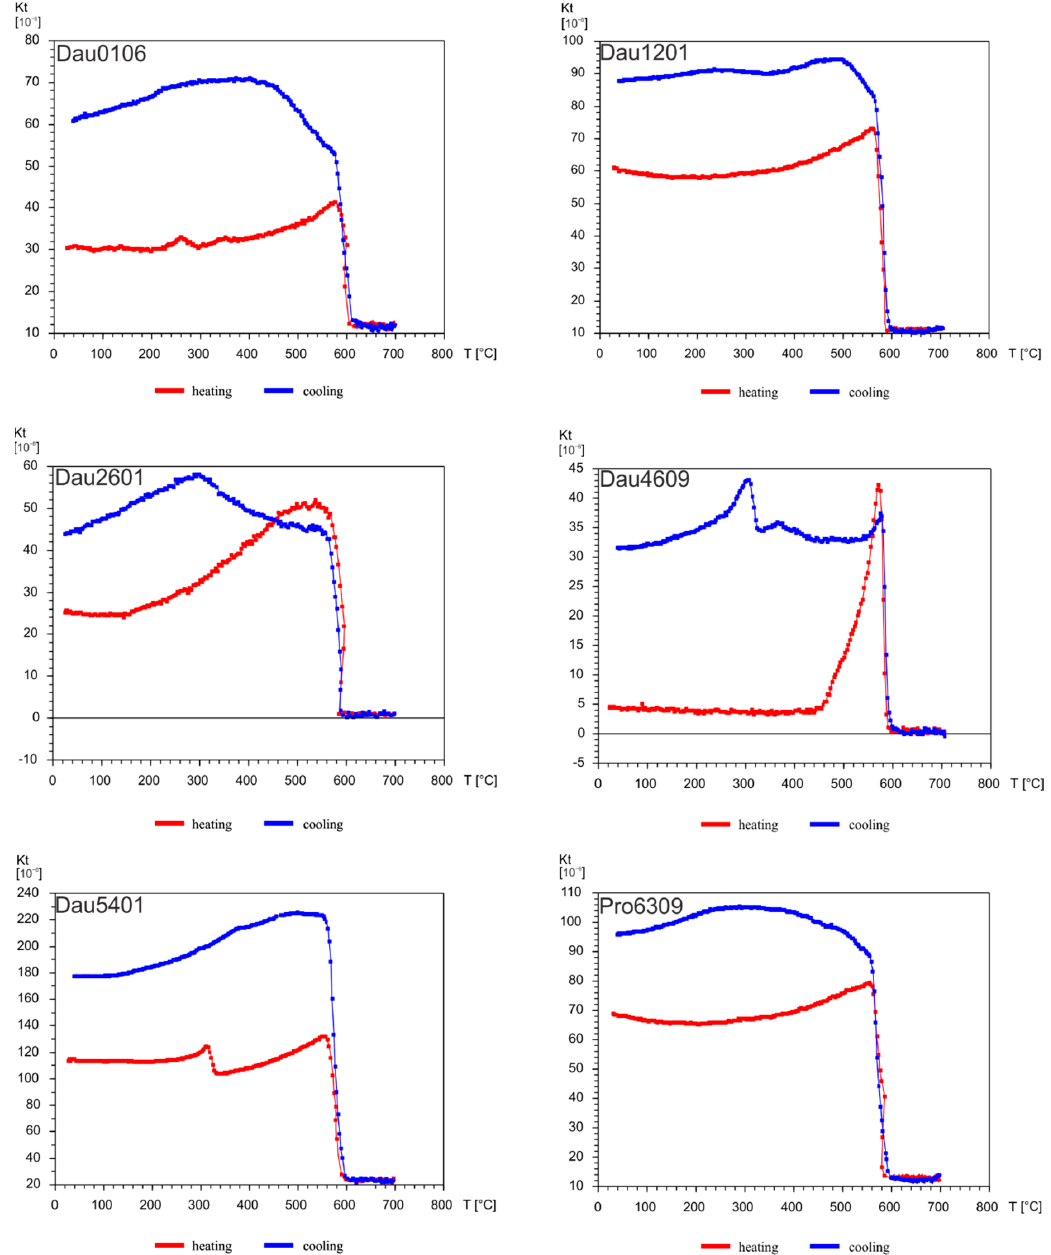
Figure 7. Temperature dependence of magnetic susceptibility for metadolerites “whole-rock” samples from south-western Oscar II Land, western Spitsbergen.